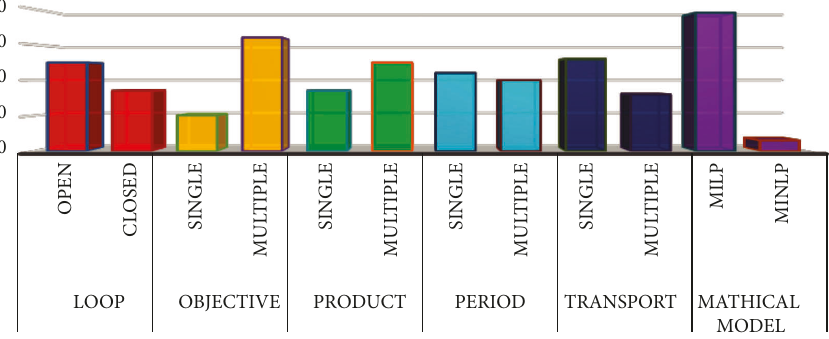
Figure 8: Modeling features of reference